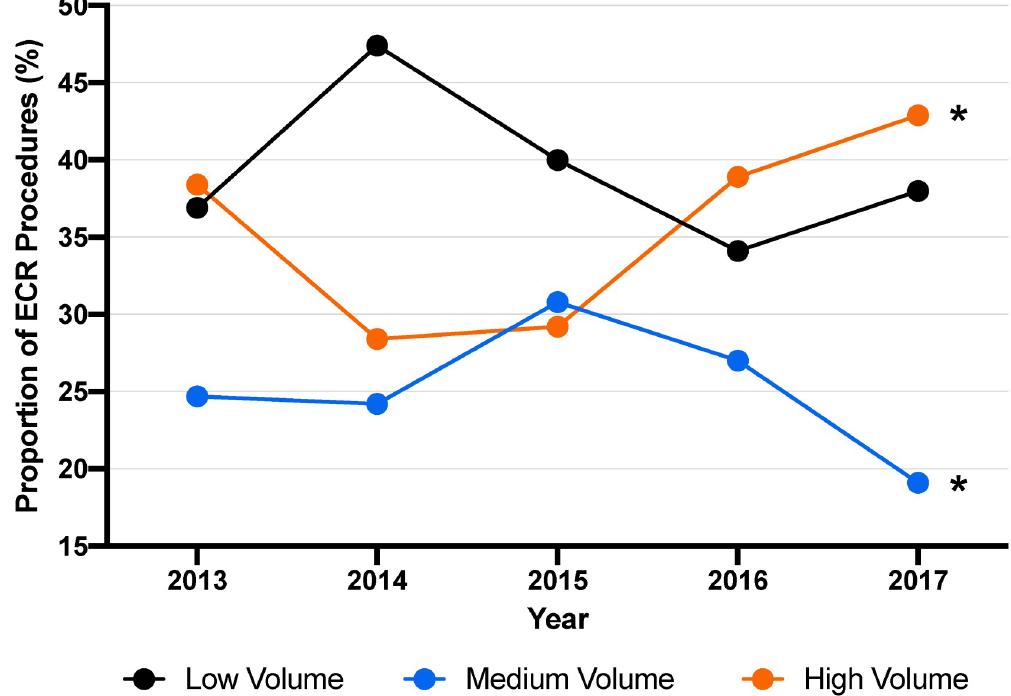
Fig 3. The proportion of extended procedures performed at high, medium, and low volume hospitals each year. � Significance at P < 0.05.